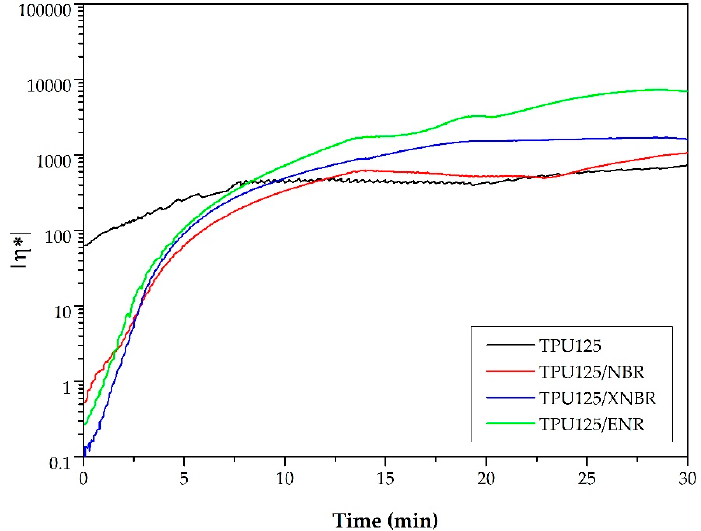
Figure 7. The simulation of the complex viscosity of the matrices in a rheometer during the production of pure TPU and TDVs.